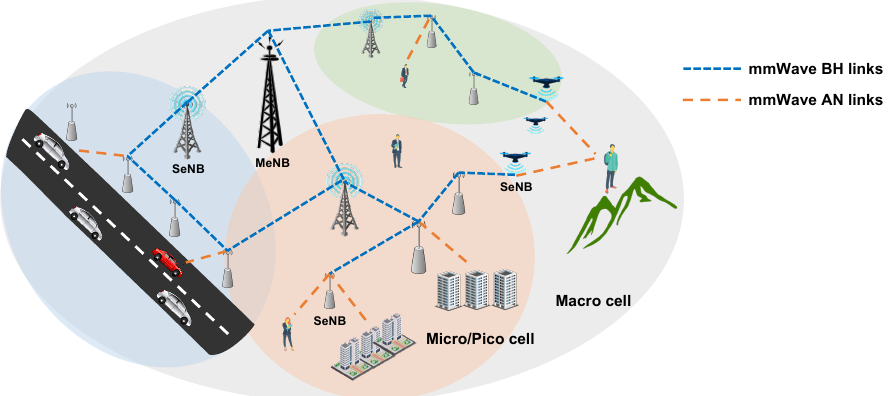
Figure 1. Heterogeneous cellular network architecture with mmWave backhaul